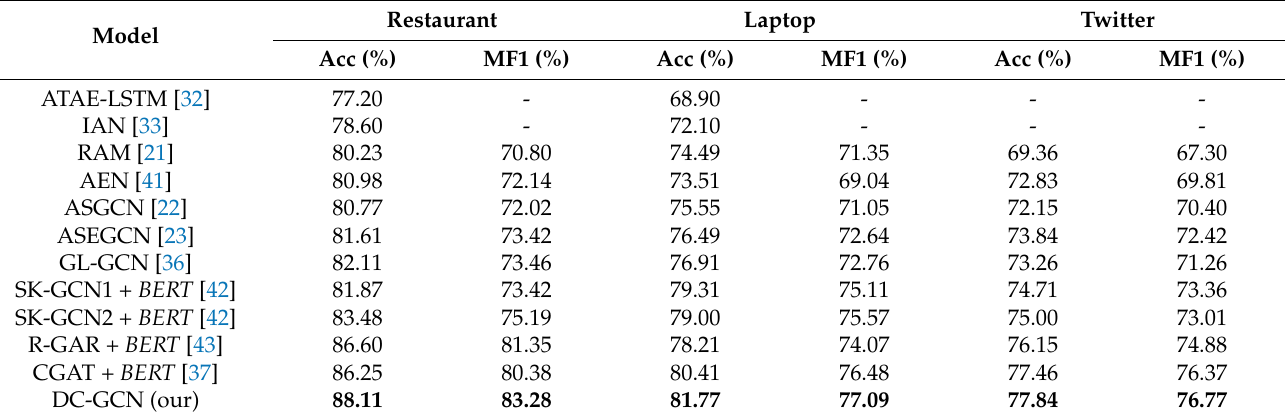
Table 3. Comparison results of different models on the three